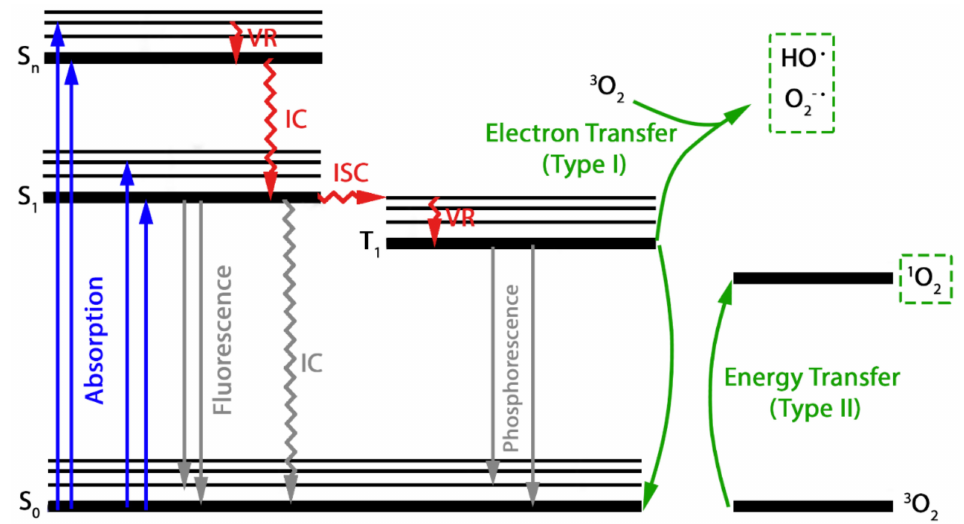
Scheme 1. Adapted Jablonski diagram depicting the relevant electronic transitions that promote ROS formation in photocatalysis (in green), corresponding deactivating mechanisms (in gray) and other ra- diationless processes (in red): VR = vibrational relaxation; IC = internal conversion; ISC = intersystem